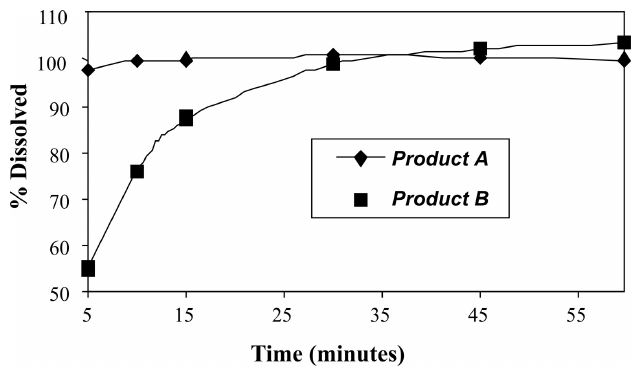
FIGURE 5 - Comparison of profiles ( Product A x Product B